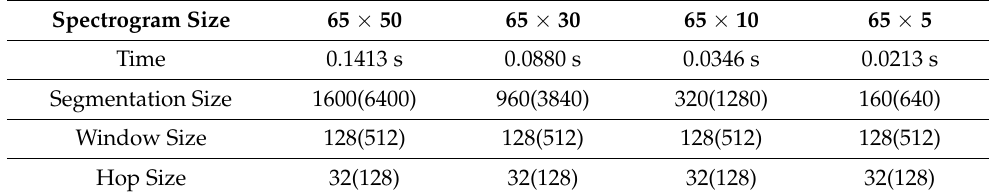
Table 3. Parameters for each spectrogram with different sizes corresponding to the time intervals.